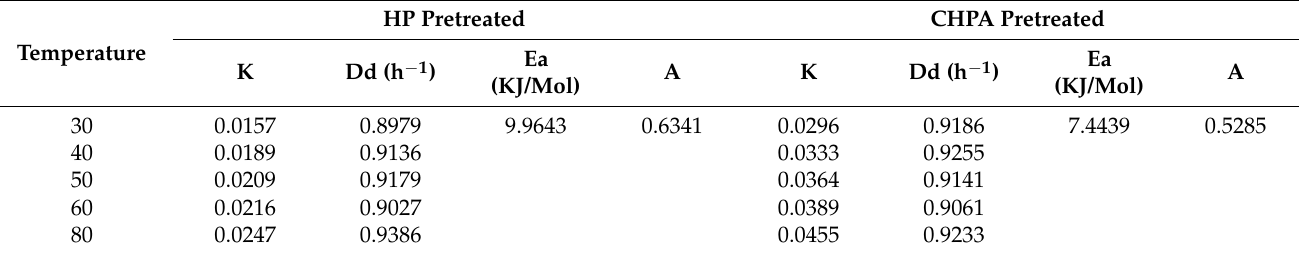
Table 3. Effect of varying pretreatment temperatures on kinetic parameters of lignin removal by linear regression of experimental